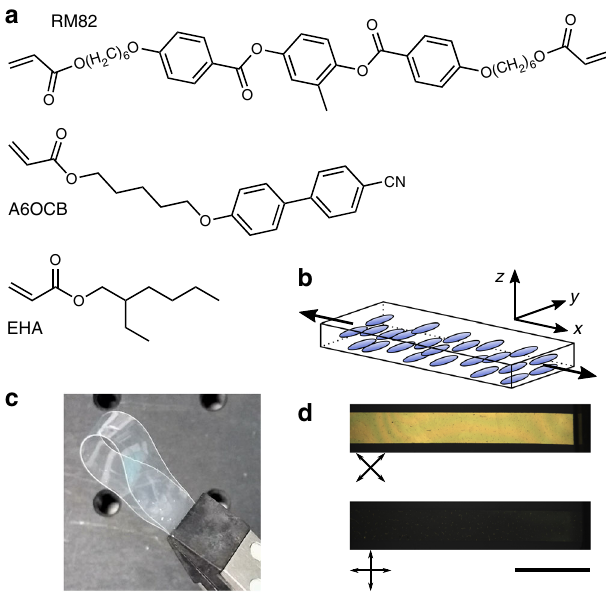
Fig. 1 Composition and macroscopic appearance of the LCE. a Chemical structures of 1,4-bis-[4-(6-acryloyloxyhex-yloxy)benzoyloxy]-2- methylbenzene (RM82), 6-(4-cyano-biphenyl-4 ’ -yloxy)hexyl acrylate (A6OCB) and 2-ethylhexyl acrylate (EHA) — the acrylate monomers used to produce the auxetic side-chain LCE. b Diagram of undeformed sample geometry with liquid crystal director parallel to the y- axis and perpendicular to the fi lm long ( x ) axis. In this work strains ( ε x )/deformations ( λ x ) are applied along the x- axis with the auxetic response observed along the z- axis. c Photograph of the fi nal LCE showing its fl exibility and high optical quality. d Polarising microscopy images of a unstrained LCE. Scale bar, 5